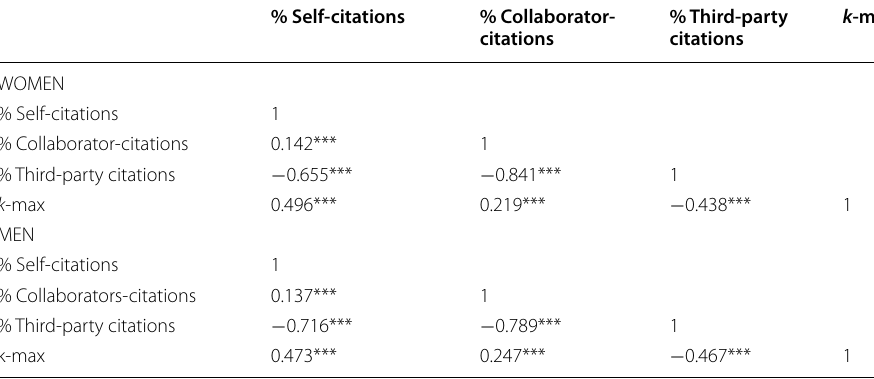
Table 6 Correlation matrix of type of citations and k